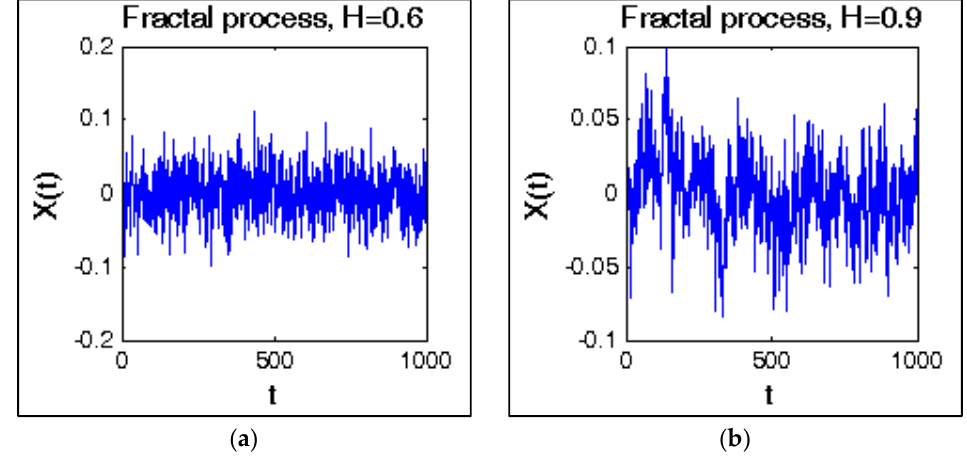
Figure 1. Simulated FGN fractal processes (a) H = 0.6 (b) H = 0.9 .